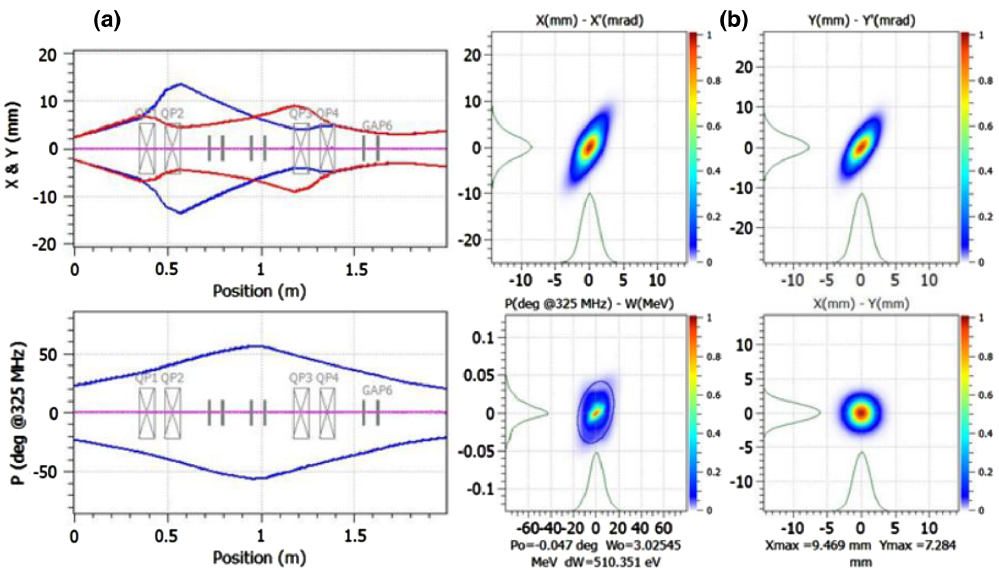
FIG. 12. (a) x, y, and phase envelope along the MEBT, (b) x-x ’ , y-y ’ , and phase-energy distribution at the exit of